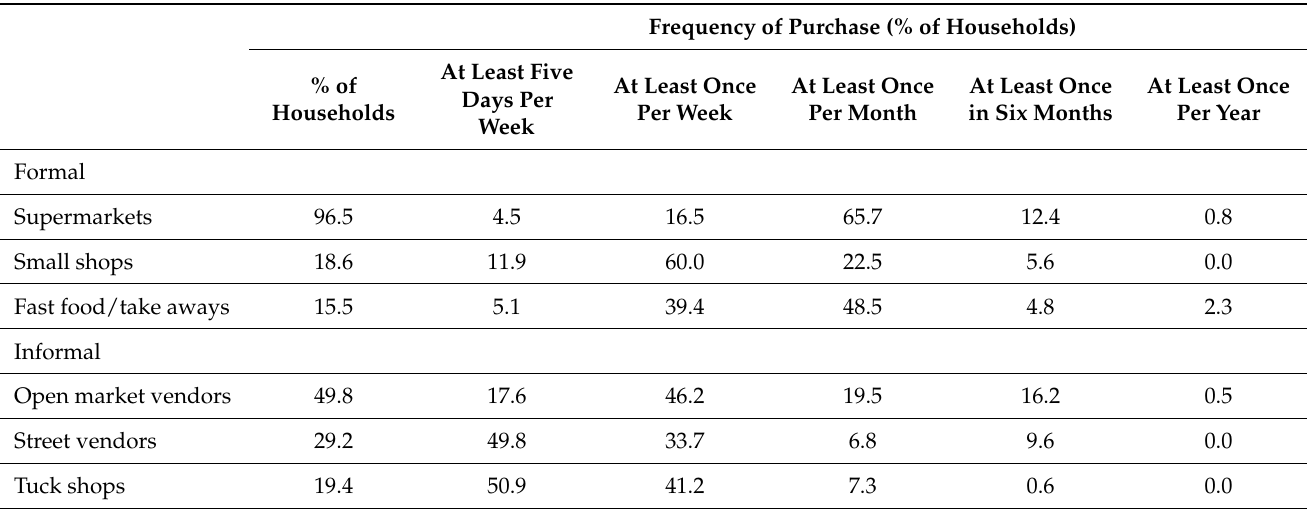
Table 2. Patronage of formal and informal food outlets in Windhoek,